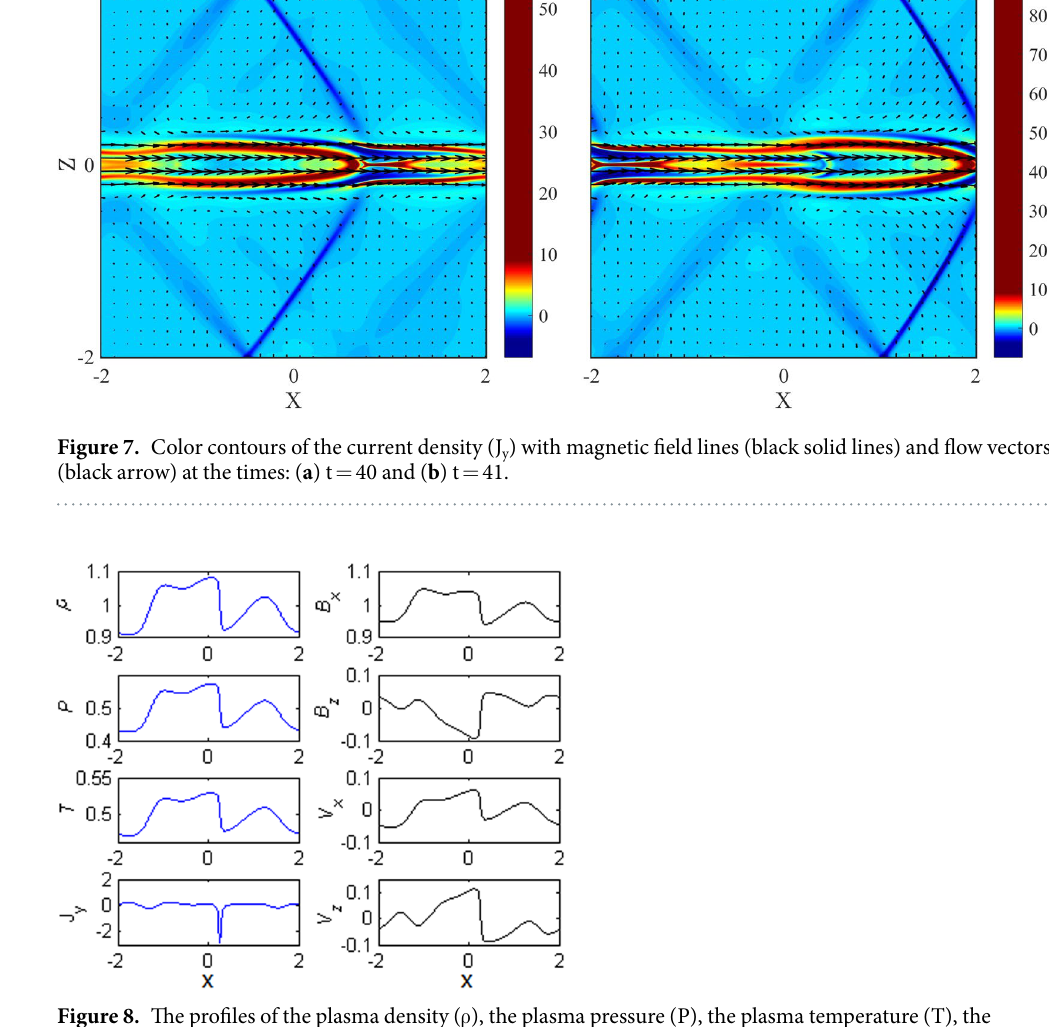
Figure 8. The profiles of the plasma density ( ρ ), the plasma pressure (P), the plasma temperature (T), the current density (J y ), the magnetic field (B x and B z ), and plasma velocity (v x and v z ) along the x axis at z = 1 for t =